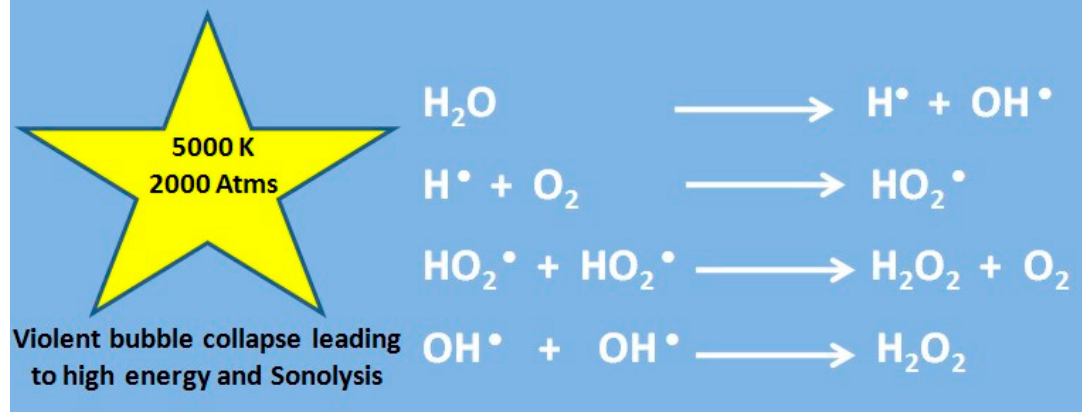
Figure 4. Schematic of water sonolysis [15].